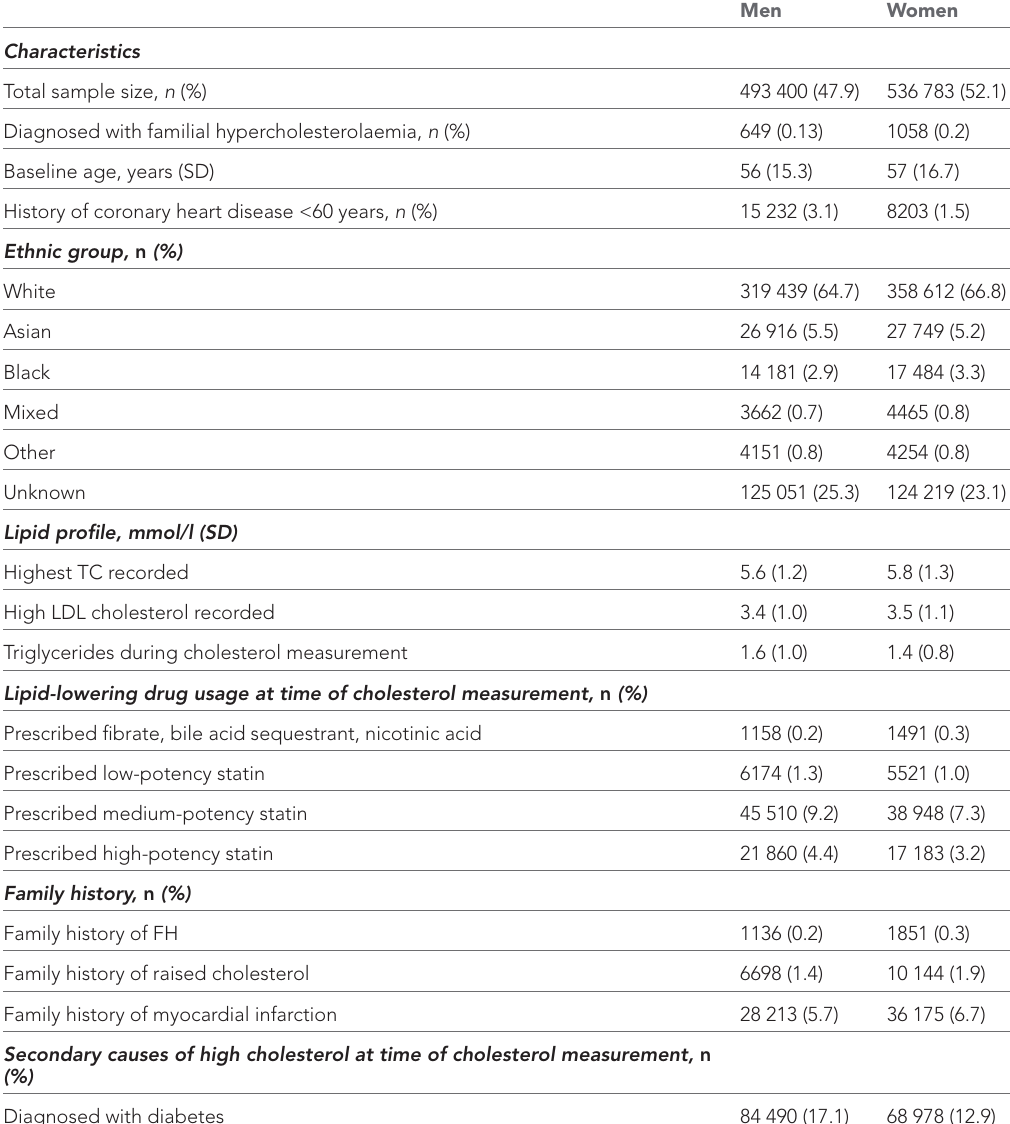
Table 1 clinical characteristics for the cohort of patients aged >16 years